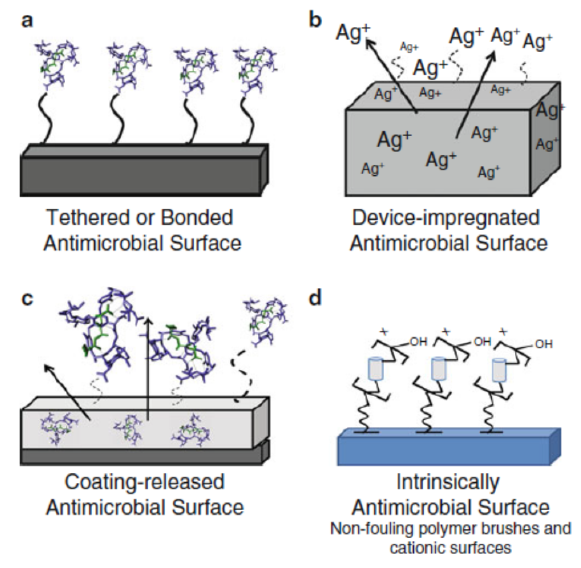
Figure 4. Mechanisms of antimicrobial surface activation [94].